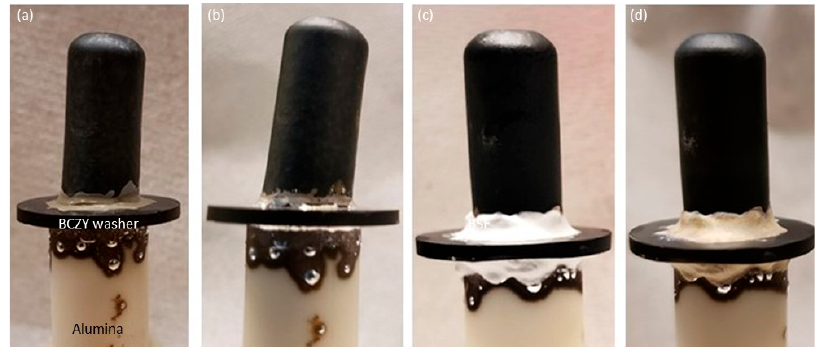
Figure 6. BCZY27-NiO/BCZY27 sintered tube on a BCZY holed washer and alumina tube: ( a ) after painting the braze paste, ( b ) after sintering the braze paste at 1080 °C, ( c ) after painting the Resbond layer onto the brazes, and ( d ) after sintering the Resbond layers at 800 °C.